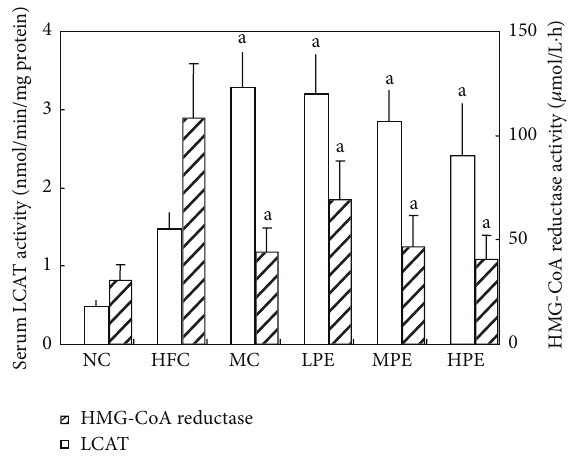
Figure 1: Effect of pollen extraction on LCAT and HMG-CoA reductase of rats ( 𝑛 = 10 ). a 𝑃 < 0.05 compared to high fat control